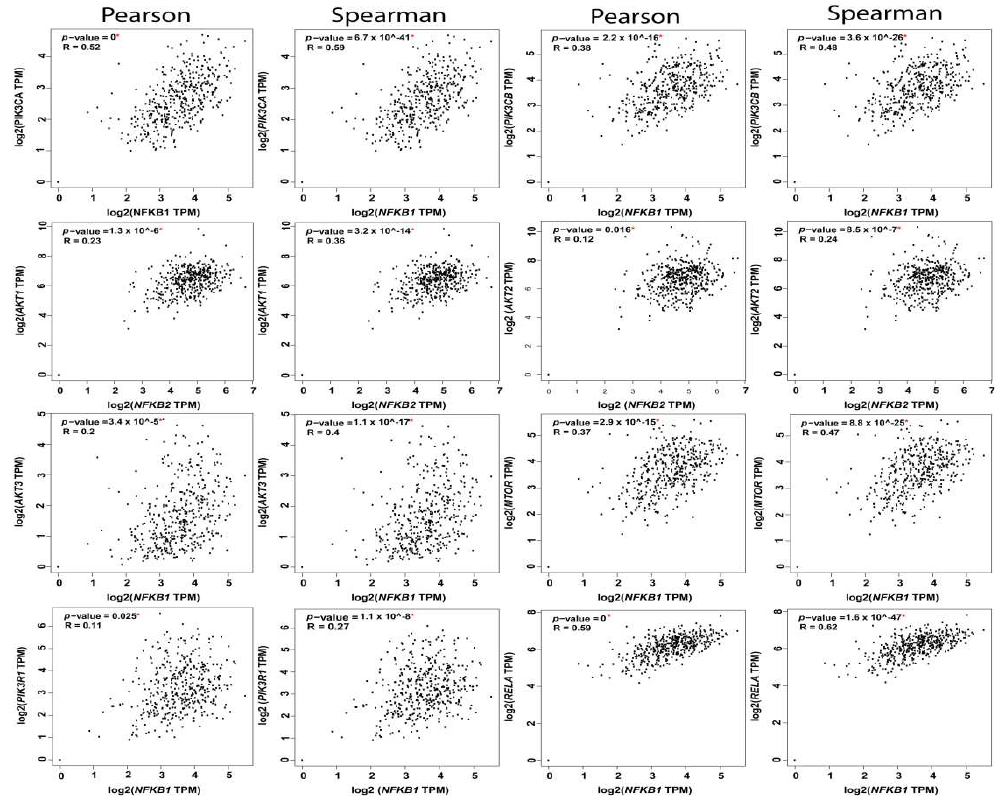
Figure 5. Correlation between NFkB1 subunit and the nodes of PI3K-AKT-mTOR and NFkB pathways.